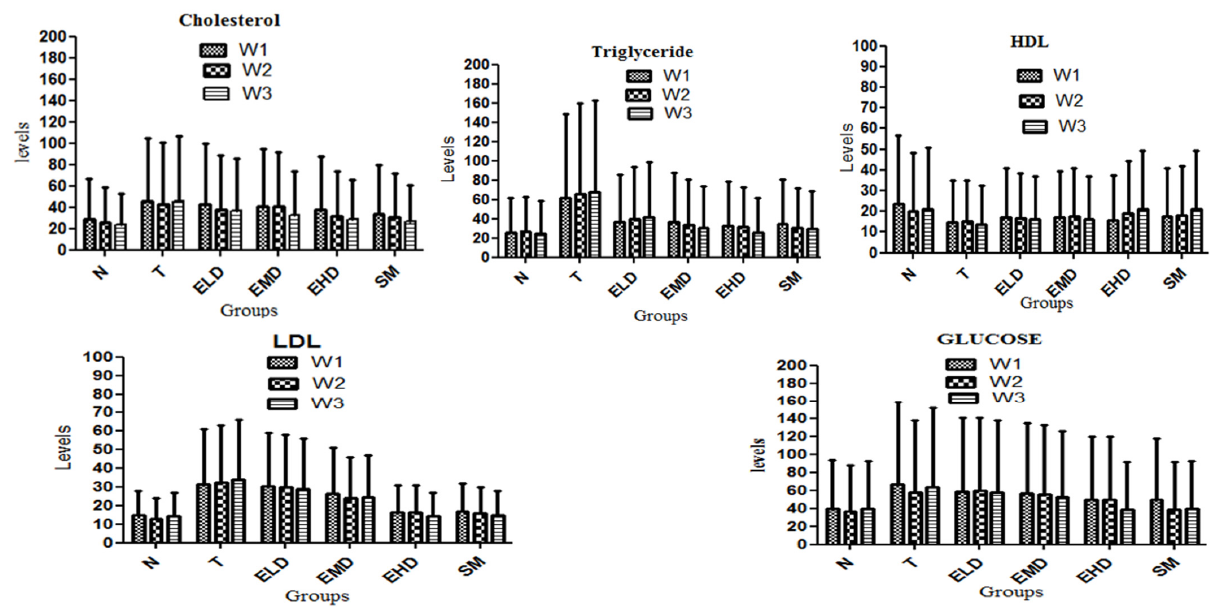
Figure 4. Graphical representation of serum markers at week 1, week 2 and week 3 of various ex ‐ perimental animal groups (Table 4).